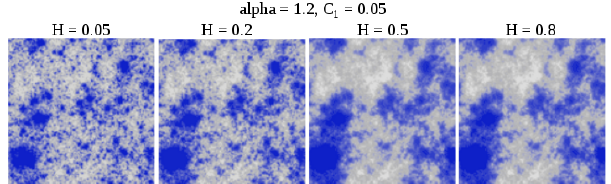
Figure B2. Illustration of the effect of H on randomly generated fields for α = 1 . 2 and C 1 = 0 . 05. Blue pixels correspond to zero intensity, whereas pixels with non-zero intensity are shown with a grayscale colormap. Taken from Lovejoy (2017).